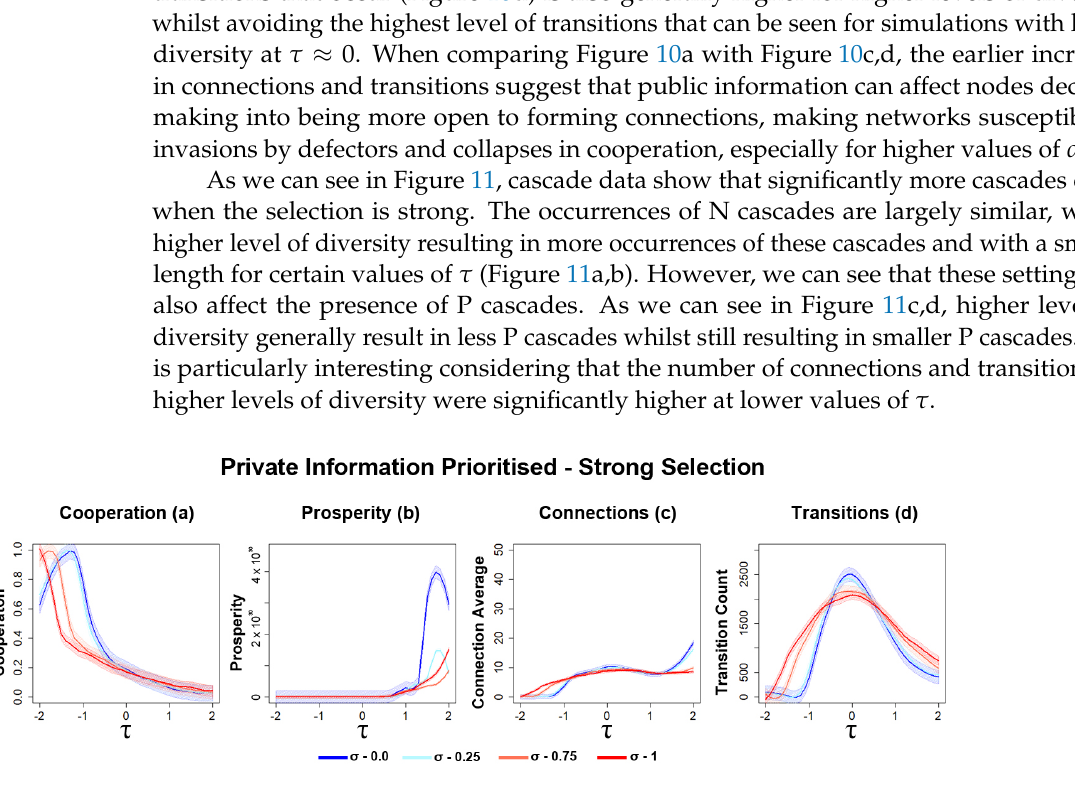
Figure 10. Public information leads to a moderate loss in cooperation when selection is strong and private information is prioritised. The plots visualise and compare the metrics of cooperation, prosperity, average connectivity and number of transitions for differing levels of opinion diversity. Data obtained by running the model for 10 8 steps with p = 0.25 and q = 0.75 and a δ setting of 0.1. τ represents the decision threshold. σ represents opinion diversity. Shading represents level of standard error calculated for each dataset. Data interpolated utilising RStudio [22]. Plots produced via RStudio utilising code found in Appendix A.